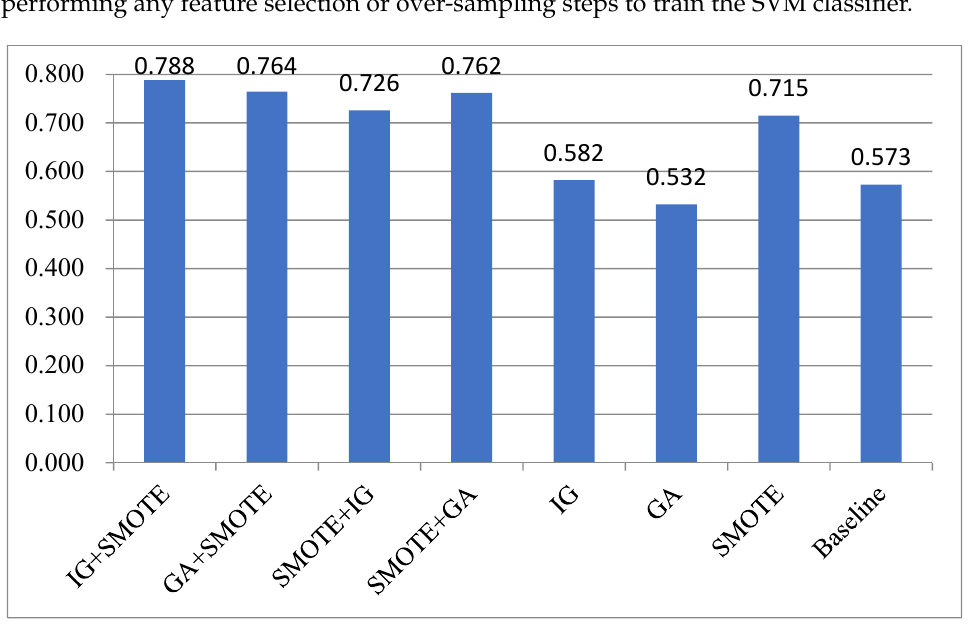
Figure 2. The type I errors of different approaches over the KDD Cup 2008 breast cancer dataset. As we can see, the combinations of feature selection and over-sampling can allow the SVM to provide higher AUC rates and related lower type I errors than the ones with fea- ture selection and over-sampling alone at the baseline. More specifically, the combination order of performing feature selection first and over-sampling second outperforms the op- posite combination order. In particular, IG+SMOTE is the best combined approach, which causes the SVM to provide an AUC rate of 0.788 and a type I error rate of 0.003, which significantly outperforms the others ( p <0.05). On the other hand, for the feature reduction result, using IG and GA produce the selection of 94 and 14, respectively. 4.2. The Breast Cancer Wisconsin Dataset Figures 3 and 4 show the AUC rates and the type I errors of different approaches, respectively. Different from the previous results, the approach that performed the best for the AUC was SMOTE (i.e., 0.962), whereas the second one was the baseline (i.e., 0.960). On the other hand, the approach that performed the best for the type I error is SMOTE+IG (i.e., 0.032), whereas the second-best ones are the baseline and SMOTE (i.e., 0.037). The